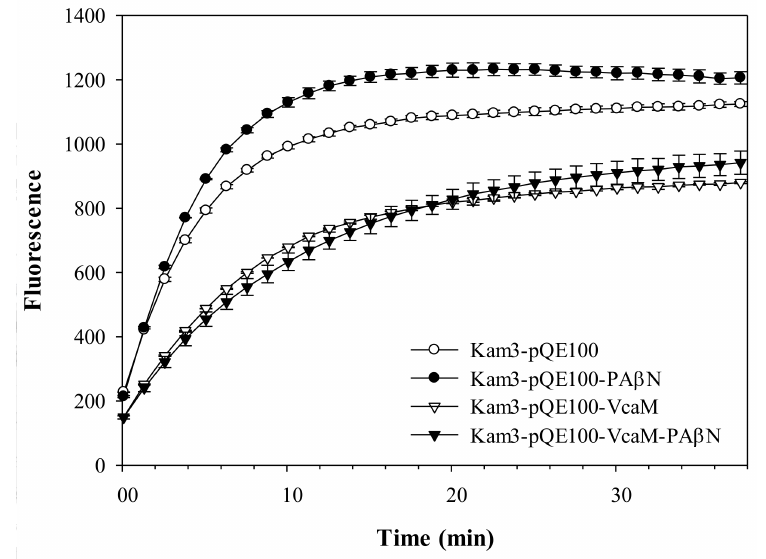
Figure 4. Drug accumulation of H33342 in E. coli Kam3 overexpressing VcaM in the presence of RND-transporter inhibitor PA β N. H33342 was incubated for 38 min in the presence of 20 µ g/mL PA β